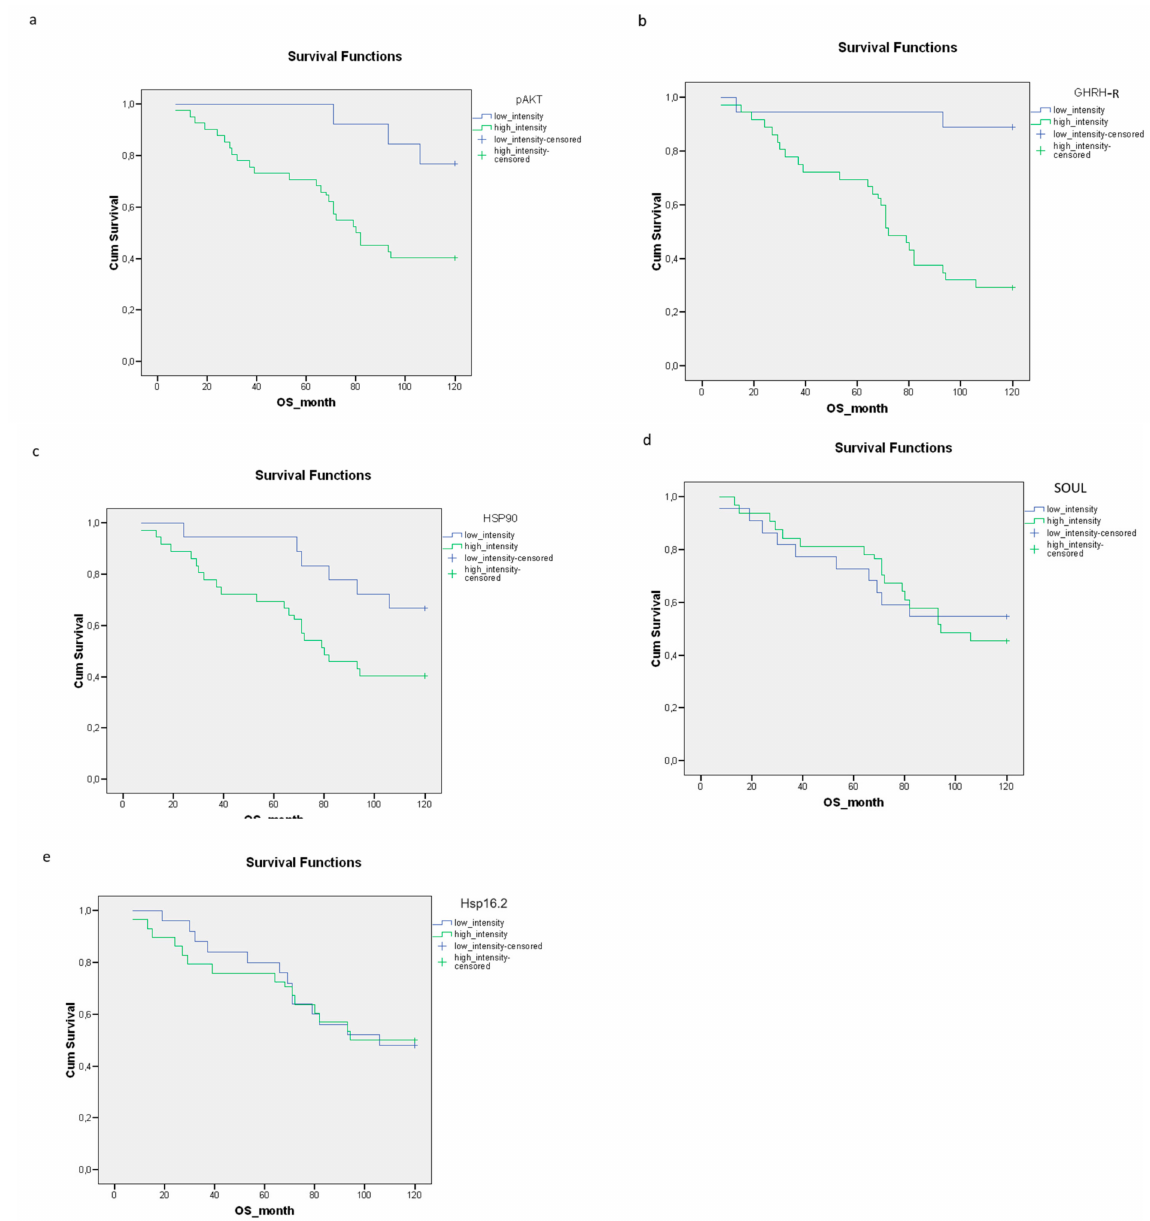
Figure 1. The relationship between the staining intensity of the pretreatment proteins ( a ) p-Akt ( p = 0.001), ( b ) GHRH-R ( p = 0.000), ( c ) Hsp90 ( p = 0.004) ( d ) SOUL ( p = 0.661) and ( e ) Hsp16.2 ( p = 0.975) and the 10-year OS rate. The effects of biological markers on the overall survival were demonstrated using Kaplan–Meier curves and the level of significance was determined using the log-rank test. Probability ( p ) values < 0.05 were considered statistically